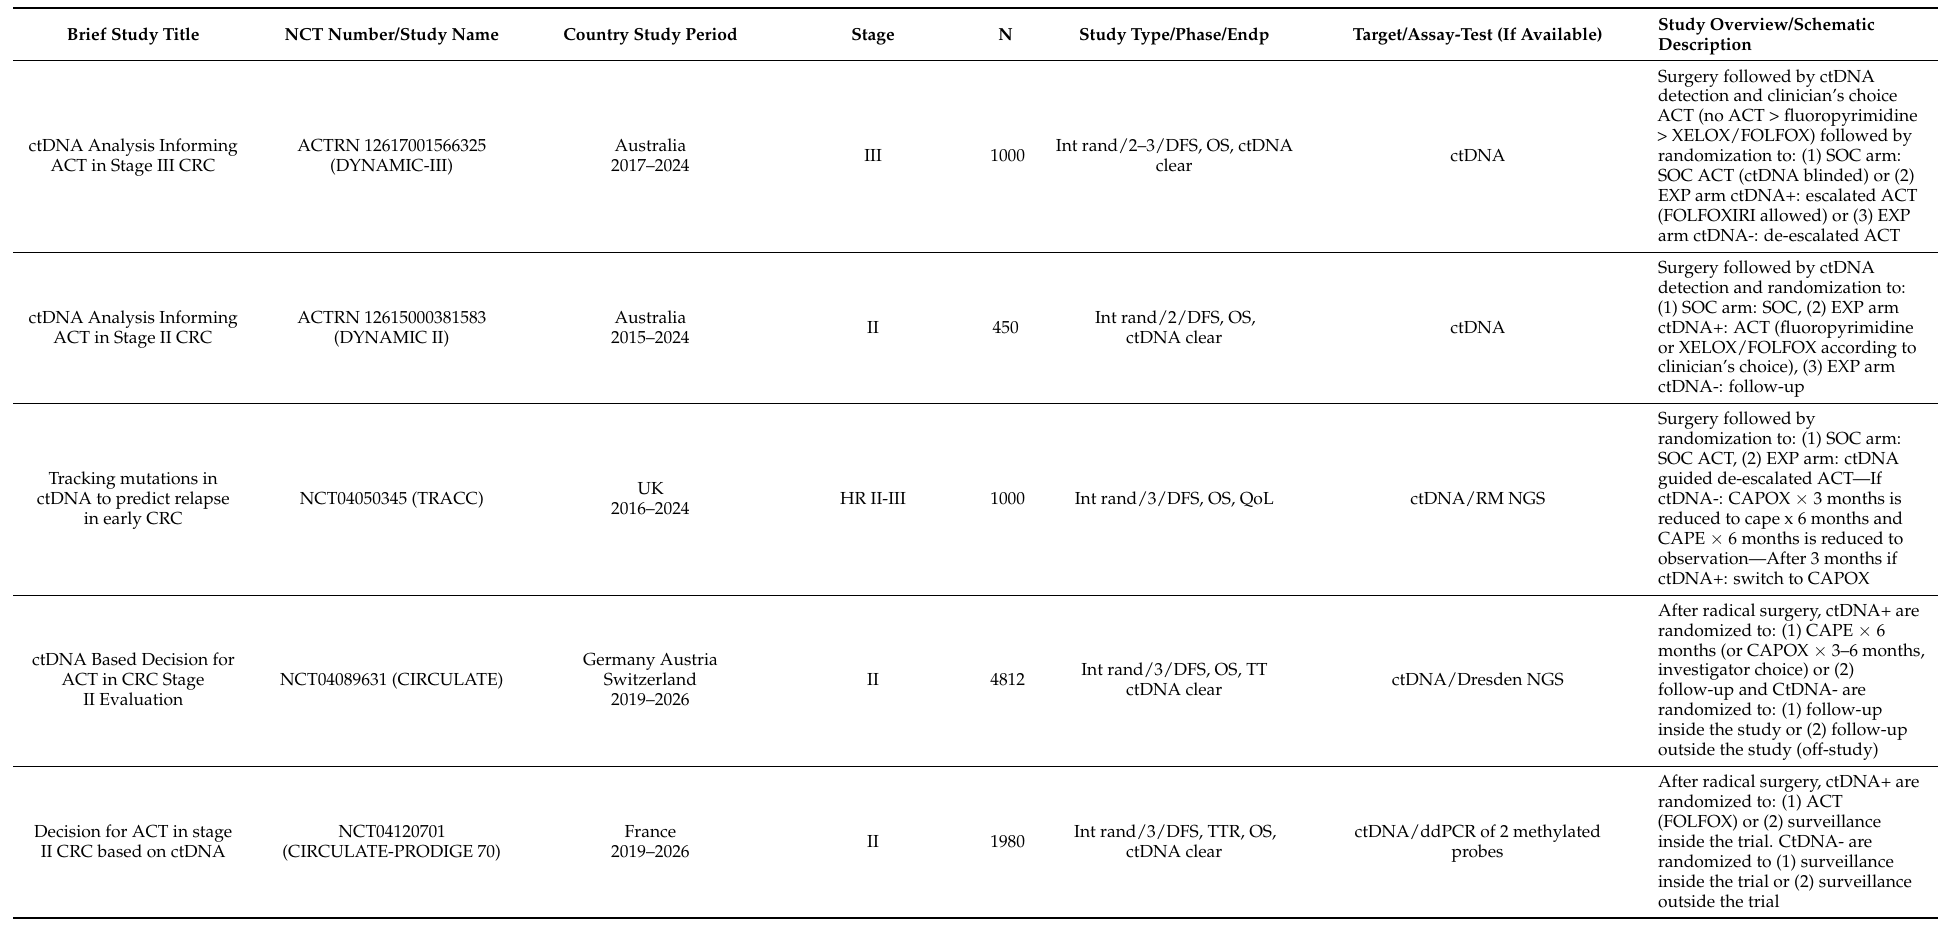
Table 1. List of major ongoing prospective trials investigating liquid biopsy in colorectal